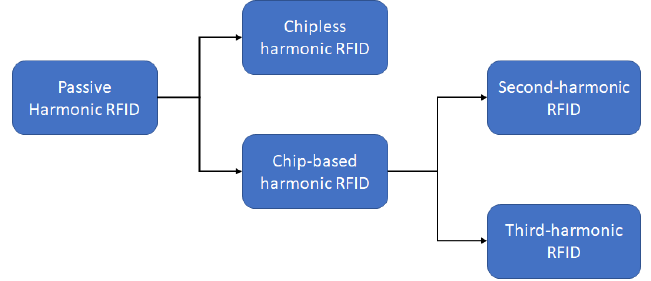
Figure 8. Recent trend in passive harmonic RFID systems.